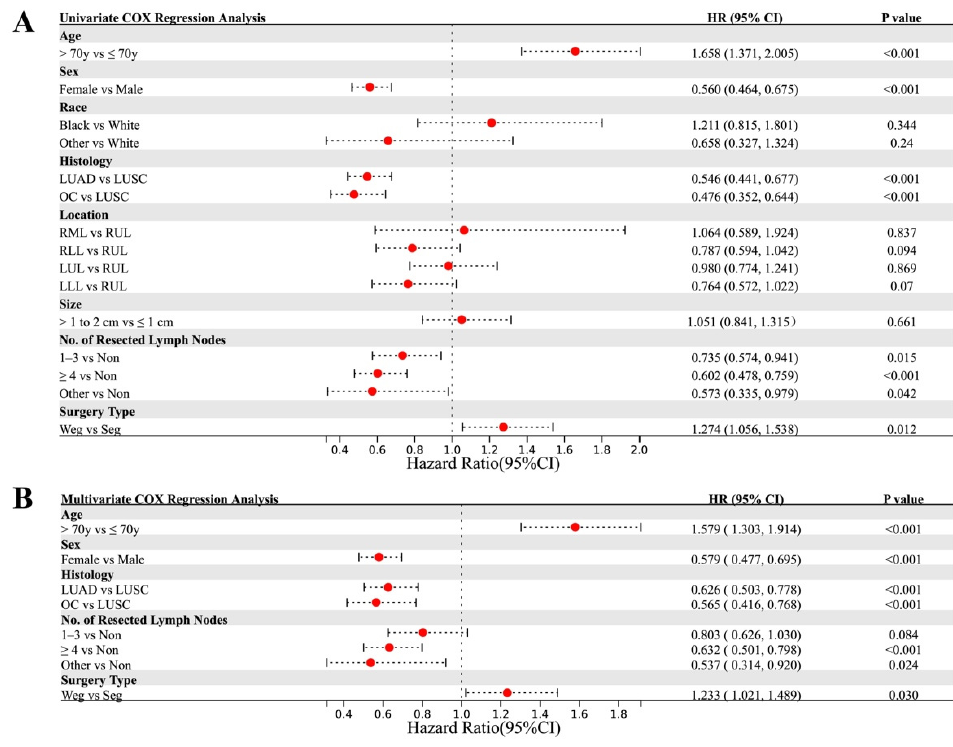
Figure 5. Univariate ( A ) and multivariate ( B ) Cox regression analyses of factors affecting overall survival.